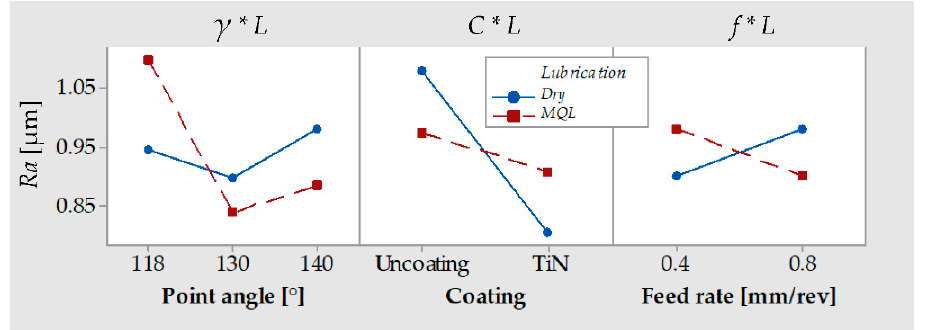
Figure 7. Scatterplot of Ra vs. point angle for both types of drill coating.